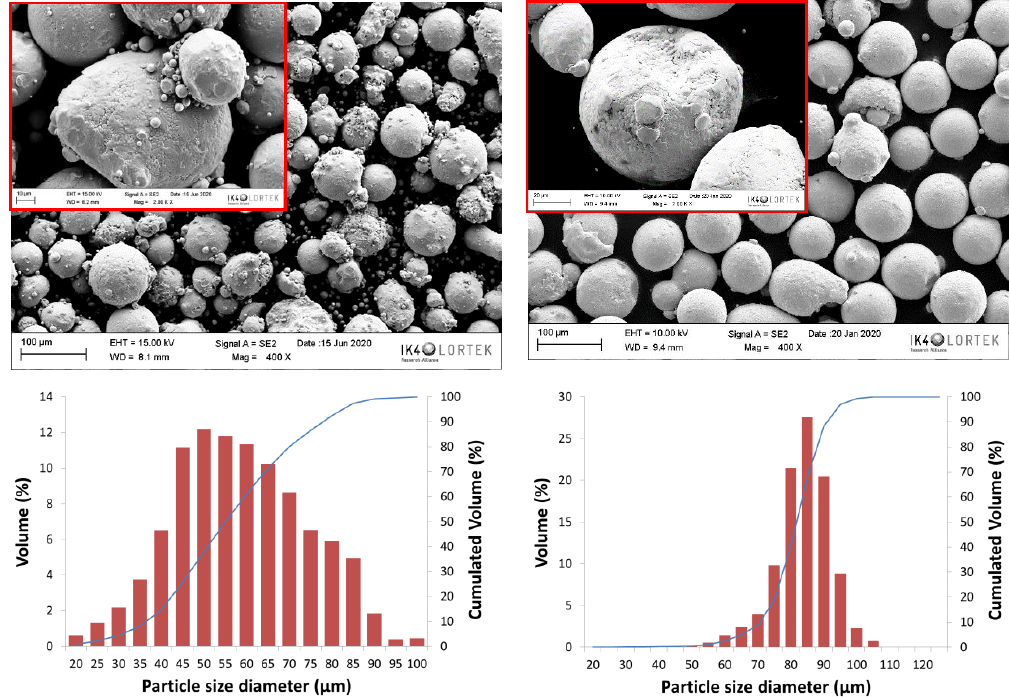
Figure 2. Characterization of pre-alloyed gas atomized powders. Morphology of the particles in SEM image (20 kV), and Granulometry and distribution analysis. SS316L powder ( left ) and IN718 Powder ( right ). The LB-DED system used for the LMD process was a 3-axis Cartesian kinematic sta-